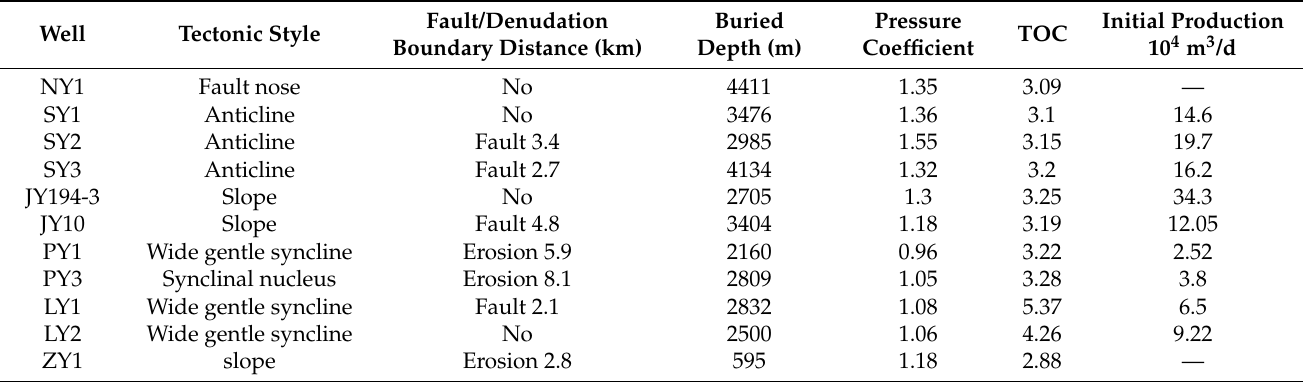
Table 4. Parameters of representative wells in southeast Chongqing. Depth refers to the bottom elevation depth of O3w. The value of pressure coefficient and TOC are the average data of O3w and the first section of Longmaxi